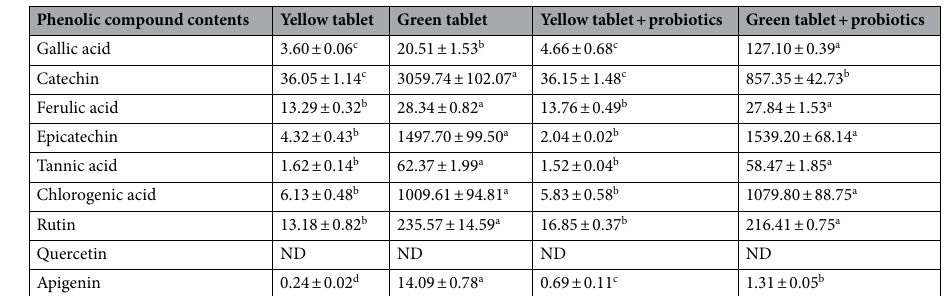
Table 2. Initial phenolic compound contents (ppm) of vegetable tablets with/without probiotics. *mean ± standard deviation. ND: not detected. a,b,c,d Different superscript letters (within same row) indicate significant differences ( p ≤